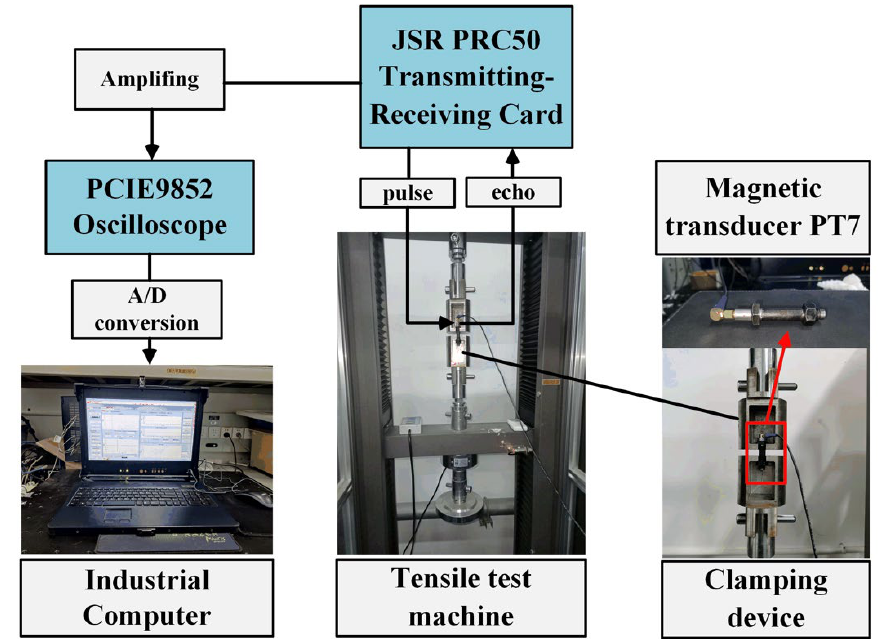
Figure 4. Schematic of the experimental configuration. Table 1. Parameters of the used ultrasonic transducer.